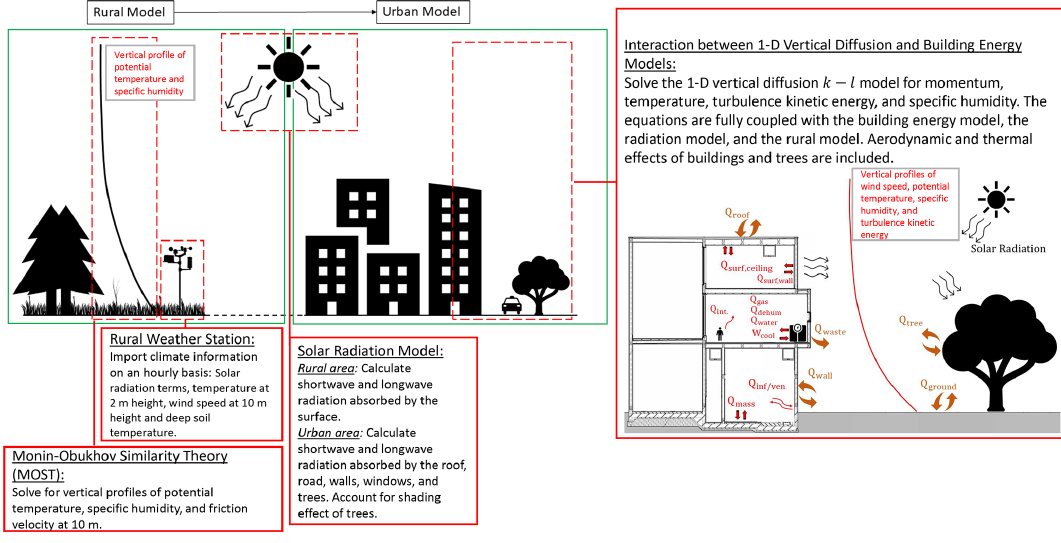
Figure 1. The schematic of the Vertical City Weather Generator (VCWG).